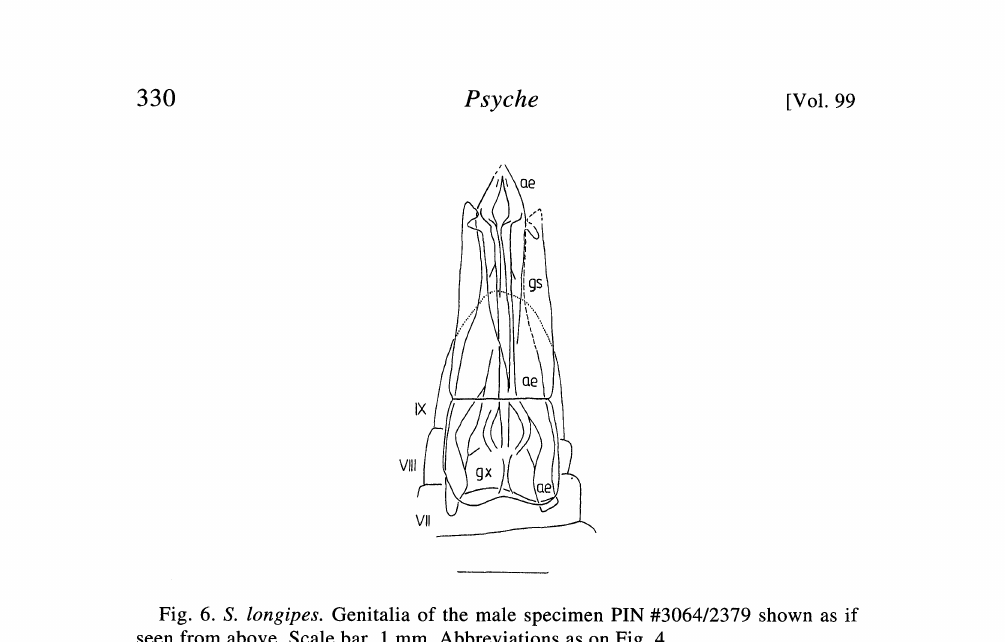
Fig. 6. S. longipes. Genitalia of the male specimen PIN #3064/2379 shown as if seen from above. Scale bar, mm. Abbreviations as on Fig. 4.